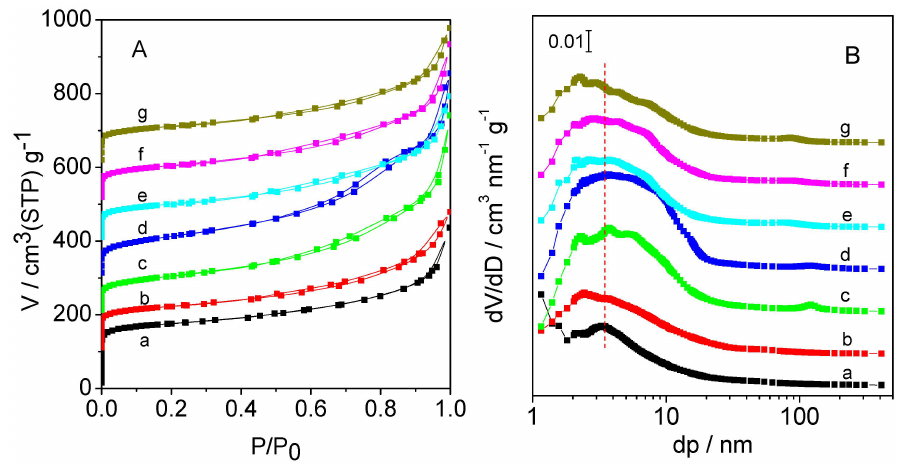
Figure 5. N 2 adsorption-desorption isotherms ( A ) and pore size distribution ( B ) of HB(77) ( a ); HB(77)-AT(0.05 M) ( b ); HB(77)-AT(0.1 M) ( c ); HB(77)-AT(0.2M) ( d ); HB(77)-AT(0.05 M)-NT(0.2 M) ( e ); HB(77)-AT(0.05 M)-NT(1 M) ( f ); and HB(77)-AT(0.05 M)-NT(2 M) ( g ) catalysts.